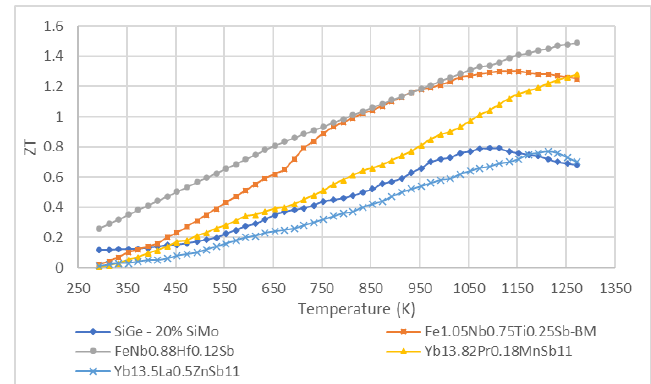
Figure 10. The thermoelectric materials enhanced through a range of nanotechnology techniques across a high-temperature range: FeNb 0.88 Hf 0.12 Sb has the highest ZT , with a peak value of 1.49 and maximum efficiency of 25.33% at 1273 K. Fe 1.05 Nb 0.75 Ti 0.25 Sb records a maximum ZT value of 1.31 at 1133 K and a maximum efficiency of 22.91% at 1273 K. This is achieved by using Ti doping and a ball milling process. Yb 13.82 Pr 0.18 MnSb 11 shows a significant improvement on Yb 14 MnSb 11 with a maximum ZT of 1.28 and a maximum efficiency of 23.23% at 1273 K. Neither SiGe—20% SiMo nor Yb 13.5 La 0.5 ZnSb 11 manage to achieve ZT values above 0.9, with maximum values of 0.88 at 1273 K and 0.77 at 1213 K, respectively. Such a dramatic rise in ZT from Yb 14 ZnSb 11 to Yb 13.5 La 0.5 ZnSb 11 is